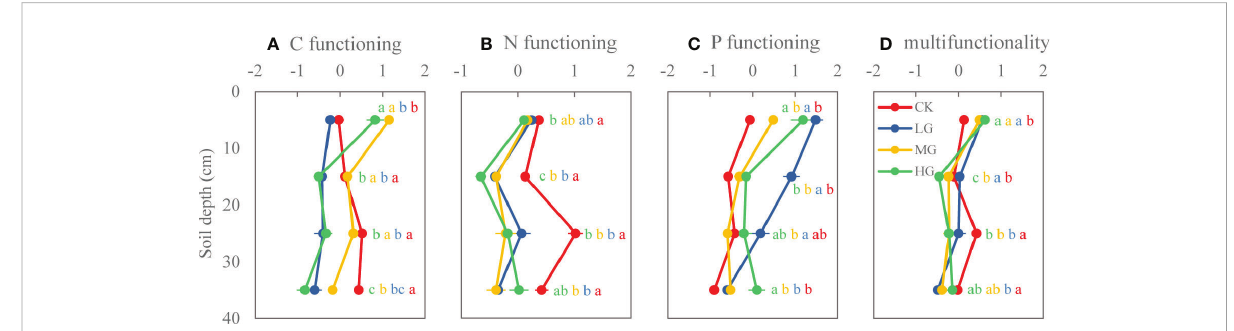
FIGURE 6 Soil functions of different soil layers under various grazing intensities. (A) Carbon functioning, (B) nitrogen functioning, (C) phosphorus functioning, (D) multifunctionality. Different lowercase letters represent signi fi cant differences among grazing intensities at the P = 0.05 level. (CK: no grazing, LG: light grazing, MG: moderate grazing, HG: heavy